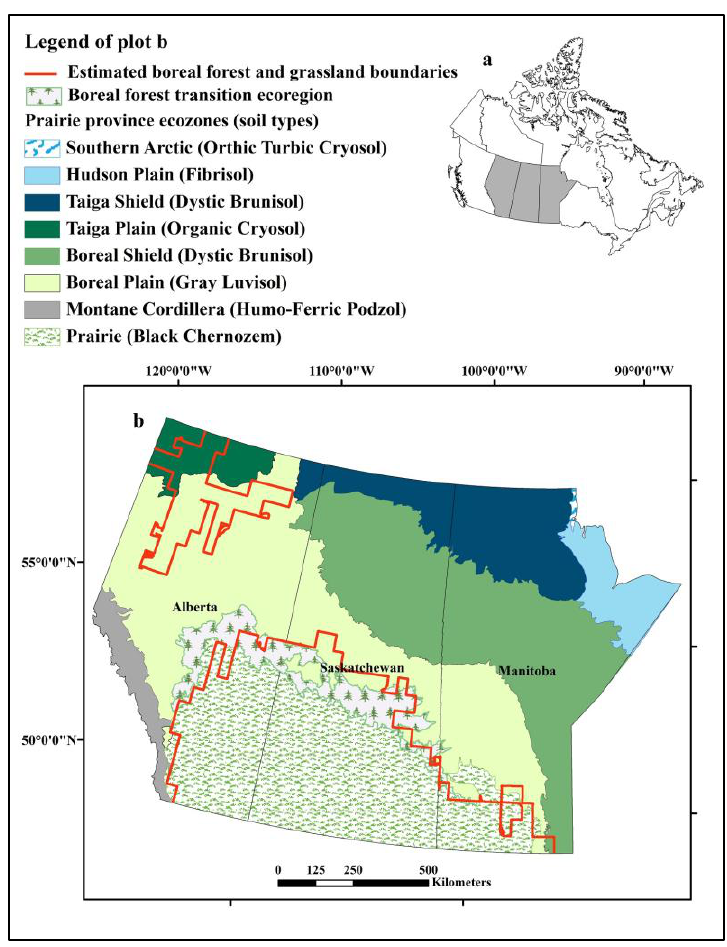
Figure 1. Distribution of ecozones and soil types in the prairie provinces of Alberta, Saskatchewan, and Manitoba, Canada and the boreal forest and prairie boundaries estimated using baseline climate conditions. ( a ) Location of prairie provinces (grey shading) in Canada. ( b ) Enlargement of Prairie provinces and distribution of